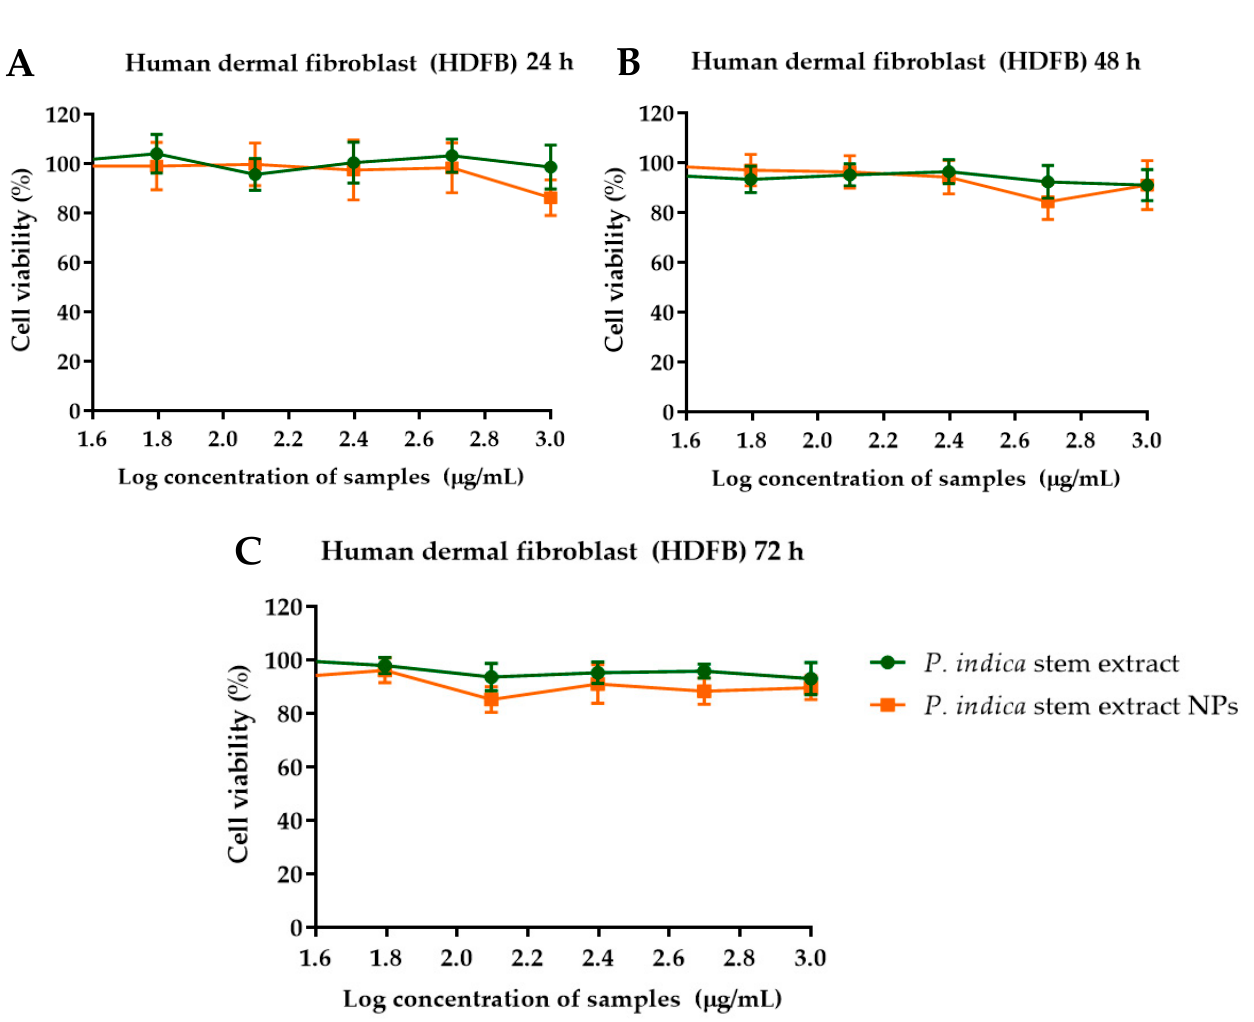
Figure 5. Effect of P. indica branch extract and NPs on human dermal fibroblast cell viability after incubation for ( A ) 24 ( B ) 48 and ( C ) 72 h. The data represent mean ± SD of three experiments.